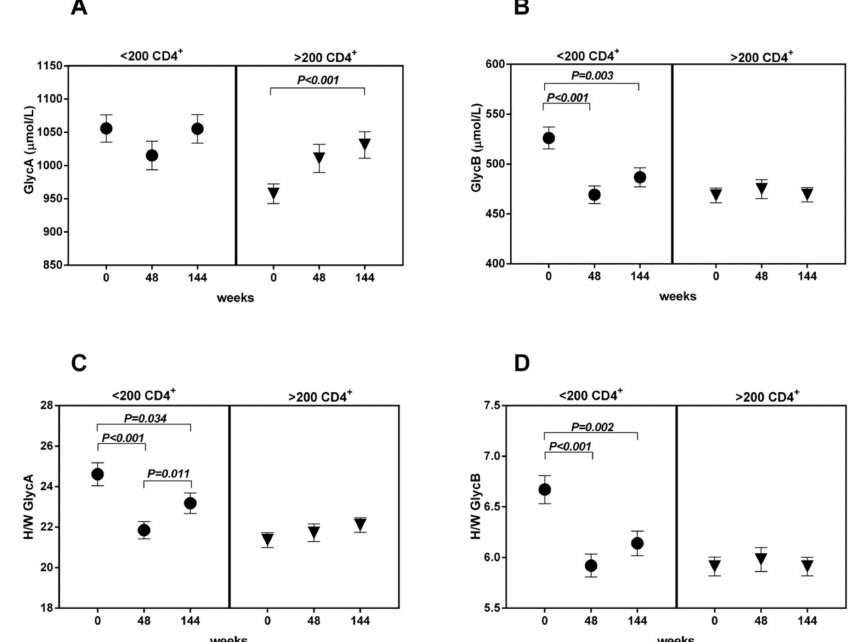
Figure 3. The evolution of glycoproteins (( A ): Glycoprotein A; ( B ): Glycoprotein B; ( C , D ) Height / Width ratio for glycoprotein A and B respectively) is represented according to groups (basal < 200 CD4 + T-cells vs. > 200 basal CD4 + T-cells) and time (weeks